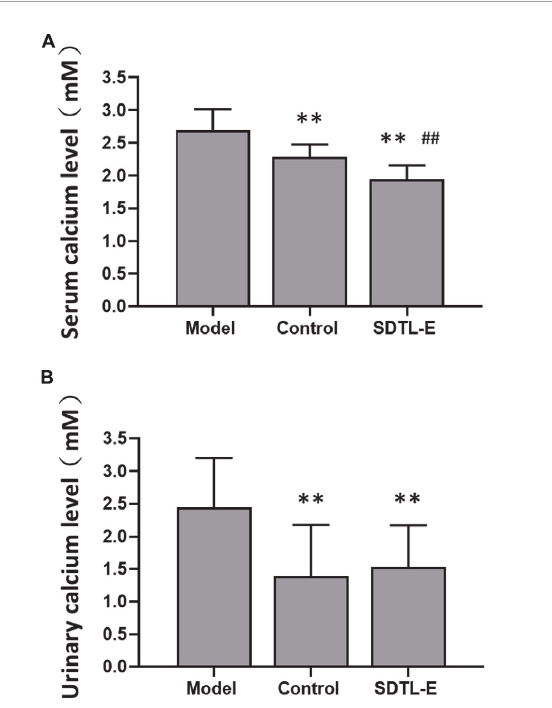
FIGURE4 SDTL-E treatment reduced serum and urinary calcium ion levels of OVX-induced osteoporosis rats. Model Group ( n = 11–12) and Control Group ( n = 10–11) rats were treated with vegetable oil. SDTL-E Group ( n = 10) rats were treated with SDTL-E. All treatments were topically applied twice daily for 20 days. Calcium ion levels in (A) serum and (B) urine were determined by calcium assay. Values are mean ± SD . ∗∗ p < 0.01 vs. Model Group. ## p < 0.01 vs. Control